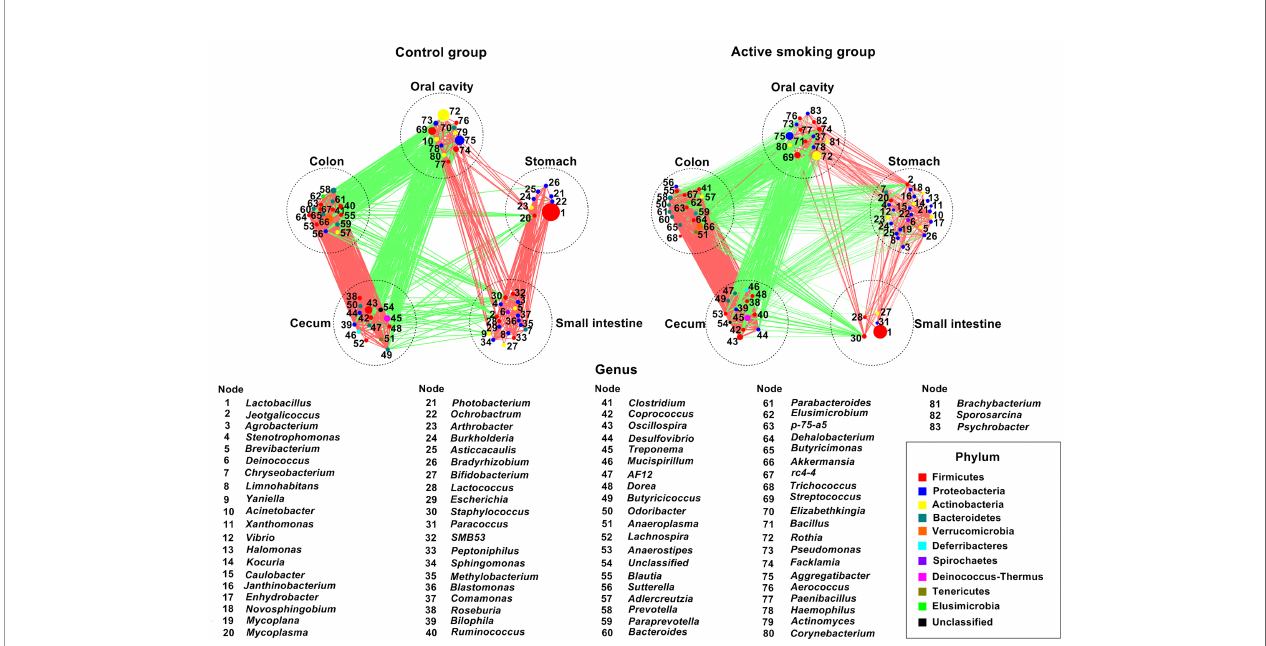
FIGURE 9 | Network plots highlight correlations between positive and negative responders at fi ve regions along the digestive tract of rats in the control group and the active smoking group, arranged in the same order. Prominent aberrations in bacterial community structure in the stomach and small intestine were determined in the active smoking group. The node size is proportional to the mean relative abundance of genera in the enriched population. Edges between nodes represent correlations between the connected nodes, with line width indicating the correlation magnitude. Only lines corresponding to correlations with magnitudes > 0.4 or < -0.4 are shown. Green edges, negative correlations; red edges, positive